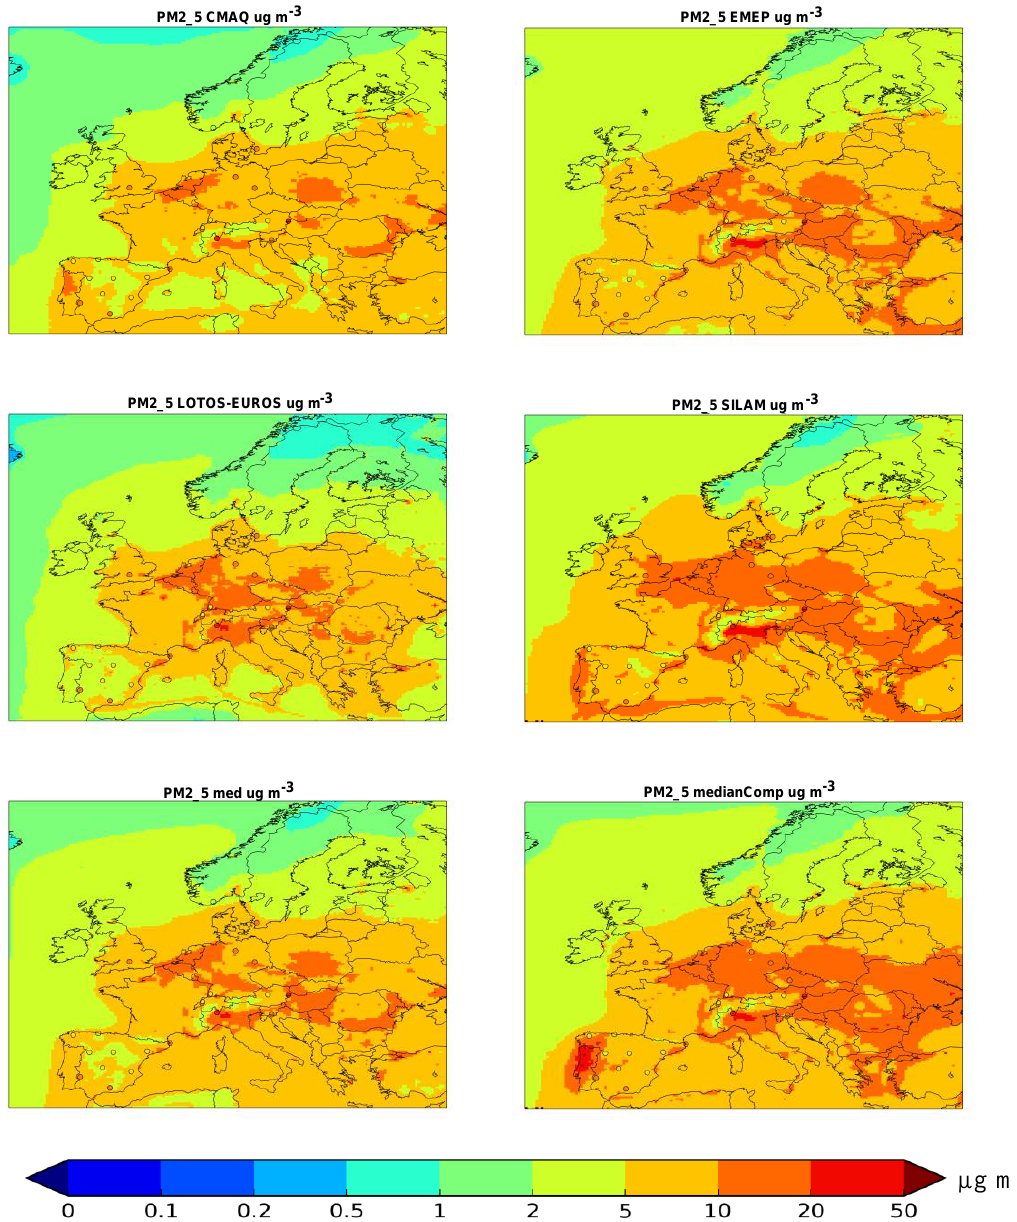
Figure 1. Annual mean dry PM 2 . 5 concentration predicted by the models, their median and medianComp (µgPMm − 3 ). The dots show the annual mean observed values in EMEP stations (only the stations with observations available for at least 75% of the time are shown).